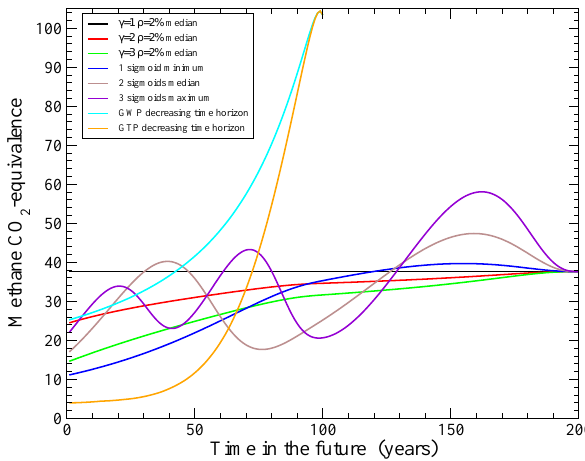
Fig. 5. Time evolution of the methane CO 2 -equivalence for a set of climate metrics: GDP with linear, quadratic and cubic damage func- tions, GDP with one sigmoid damage function, GDP with the sum of two or three sigmoid damage functions, GWP with decreasing time horizon (from 100yr to 1yr), GTP with decreasing time hori- zon (from 100yr to 1yr). The legend box indicates if the minimum, median or maximum warming scenario was used. The figure shows the case without the CH 4 conversion to CO 2